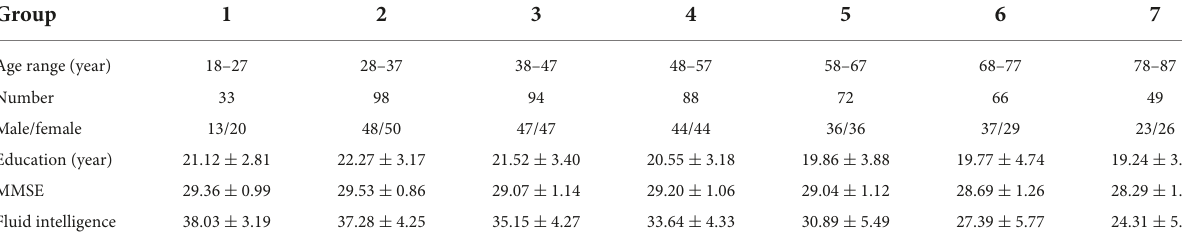
TABLE 1 Demographic data and cognitive measures of participants in each group.